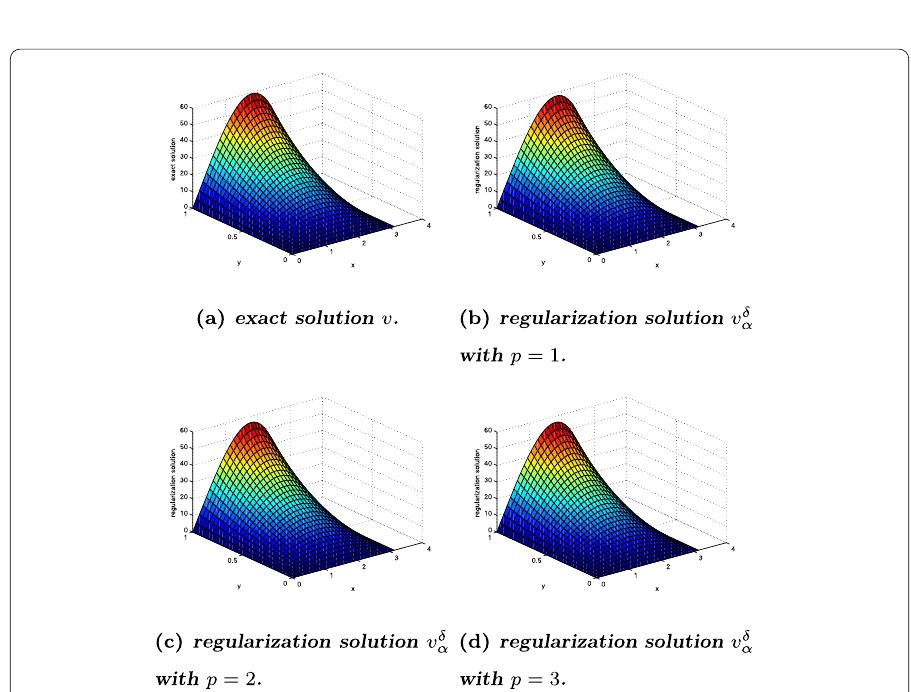
Figure 7 ε = 1 × 10 –3 , k = 1.2